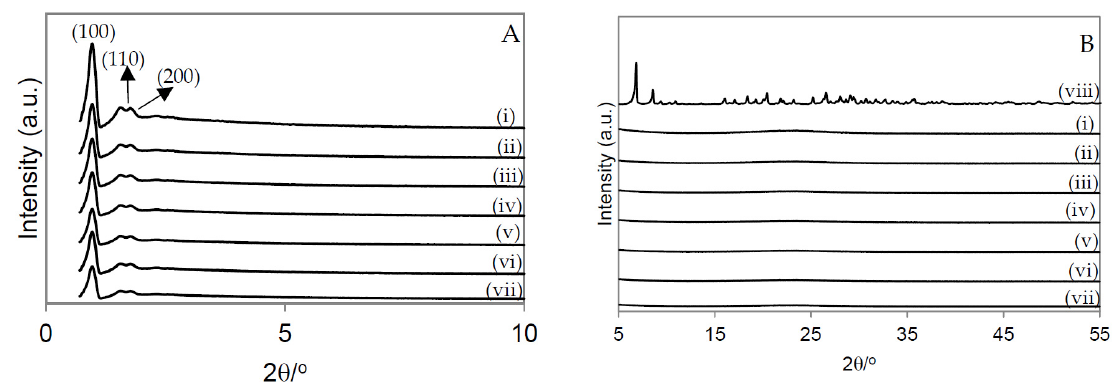
Figure 4. X-ray diffractograms of the materials. ( A ) 2 θ region of 0.7° to 10.0°; ( B ) 2 θ region of 5.0° to Figure 4. X‑ray diffractograms of the materials. ( A ) 2 θ region of 0.7 55.0°; (i) SBA-15; (ii) SBA-15-SO 3 H; (iii) PW1-SBA-15-SO 3 H; (iv) PW2-SBA-15-SO 3 H; (v) ◦ 55.0 ; (i) SBA‑15; (ii) SBA‑15‑SO 3 H; (iii) PW1‑SBA‑15‑SO 3 H; (iv) PW2‑SBA‑15‑SO 3 H; (v) PW3‑SBA‑ PW3-SBA-15-SO 3 H; (vi) PW4-SBA-15-SO 3 H; (vii) PW5-SBA-15-SO 3 H; (viii) PW. 15‑SO 3 H; (vi) PW4‑SBA‑15‑SO 3 H; (vii) PW5‑SBA‑15‑SO 3 H; (viii) PW.